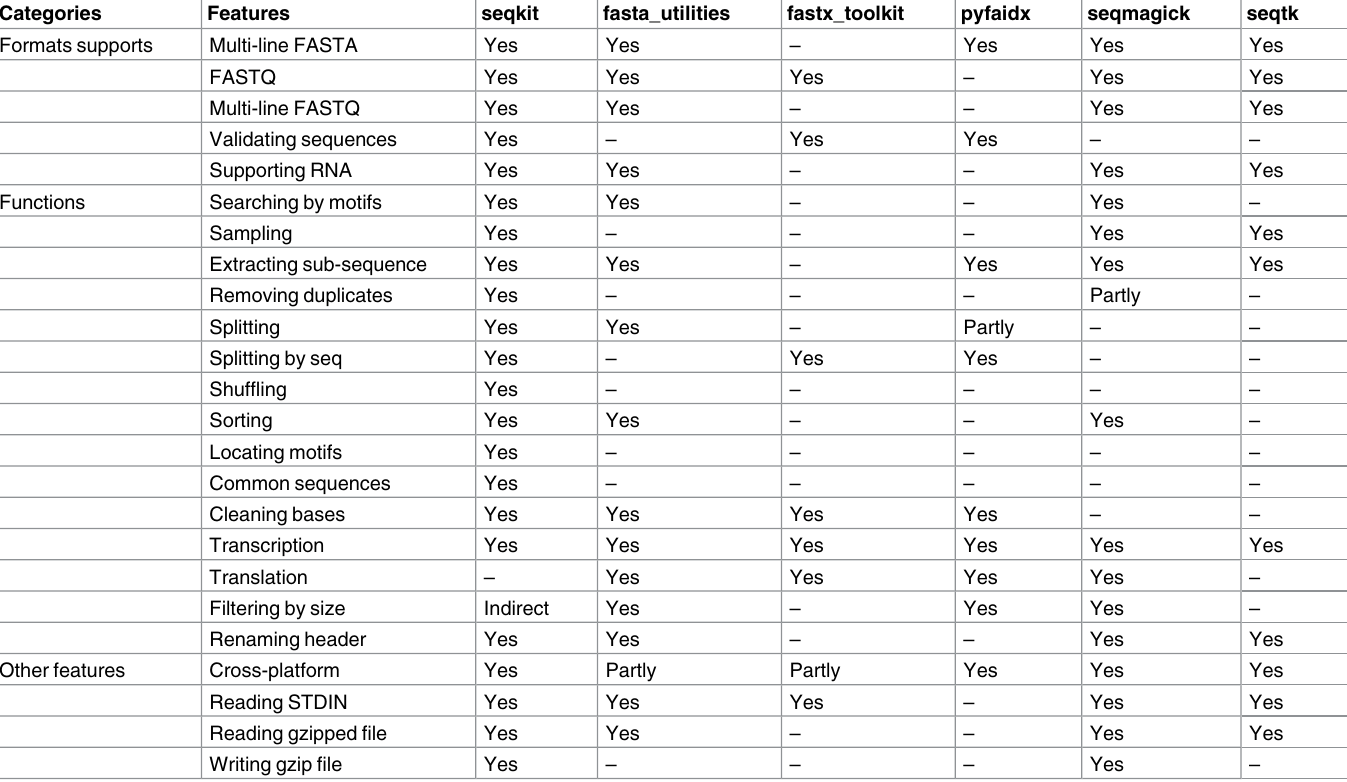
Table 2. Overview FASTA/Q processing tool